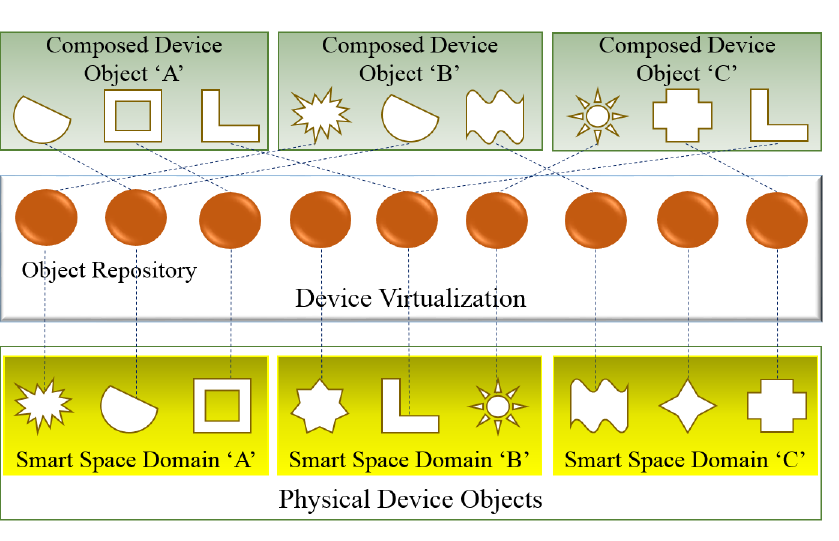
Figure 2. Composition, collaboration and harmonization of VOs for services